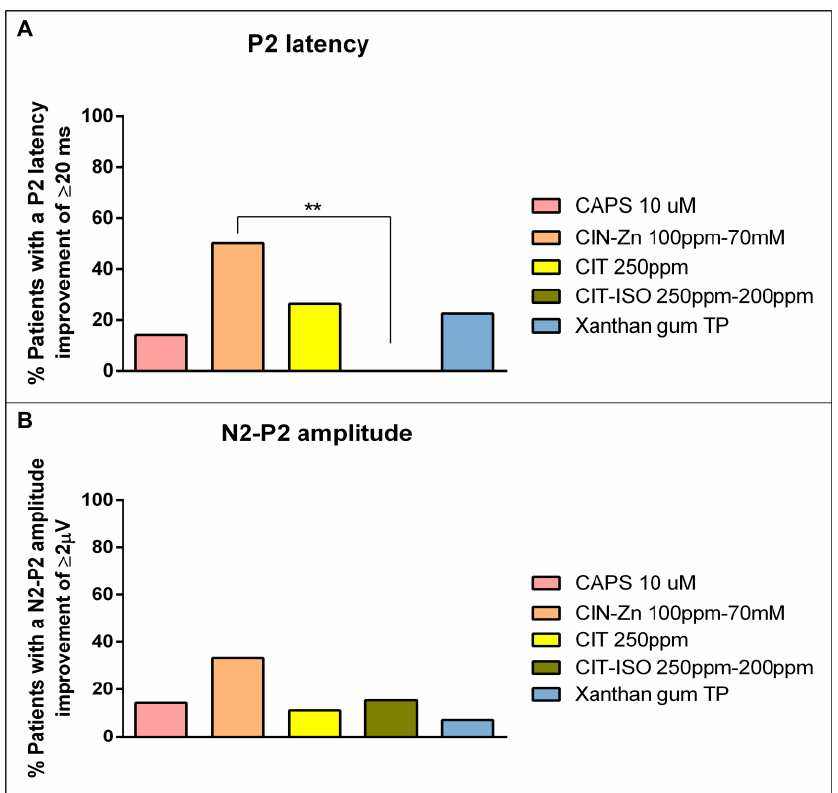
Figure 7. Graphical representation of percentage of patients that improved P2 peak latency ( A ) by at least 20 ms and N2-P2 amplitude ( B ) by 2 μ V. CAPS: capsaicin; CIN-Zn: cinnamaldehyde-zinc; CIT: citral; CIT-ISO: citral-isopulegol; TP: thickening product. **: p < 0.01.